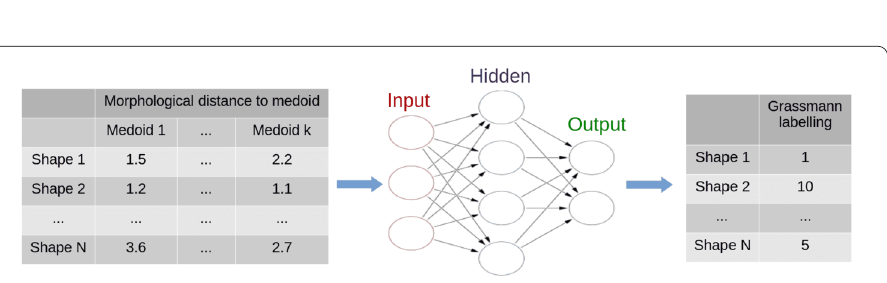
representing 90 % of the initial set, and a validation set representing the remaining 10% of the initial set of data. The validation set provides a stop criterion. Loss and accuracy curves, computed using (7), are shown in Fig.